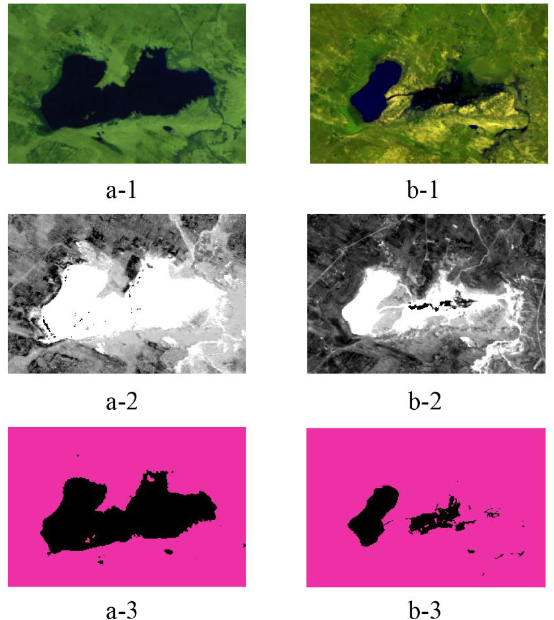
Figure 2. Example of the remote sensing extracting water area of Bojiang Lake based on MNDWI . The date of used images in Figure a and b are 28/September/1995 and 28/August/2013, respectively. ( a-1 ) and ( b-1 ) show the false color composite images of Bojiang Lake by SWIR2, SWIR1 , and Green bands. ( a-2 ) and ( b-2 ) show the calculated results of MNDWI . ( a-3 ) and ( b-3 ) show the lake water surface with the MNDWI threshold value of 0.35 (the black regions).